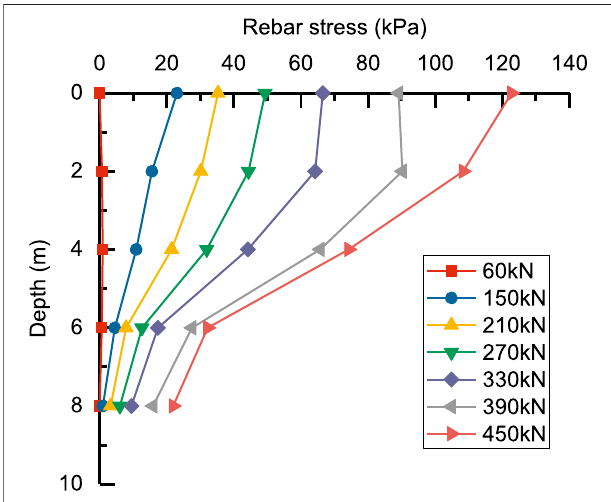
FIGURE 6 | Stress variation of TCP2 with depth under different loading stages.